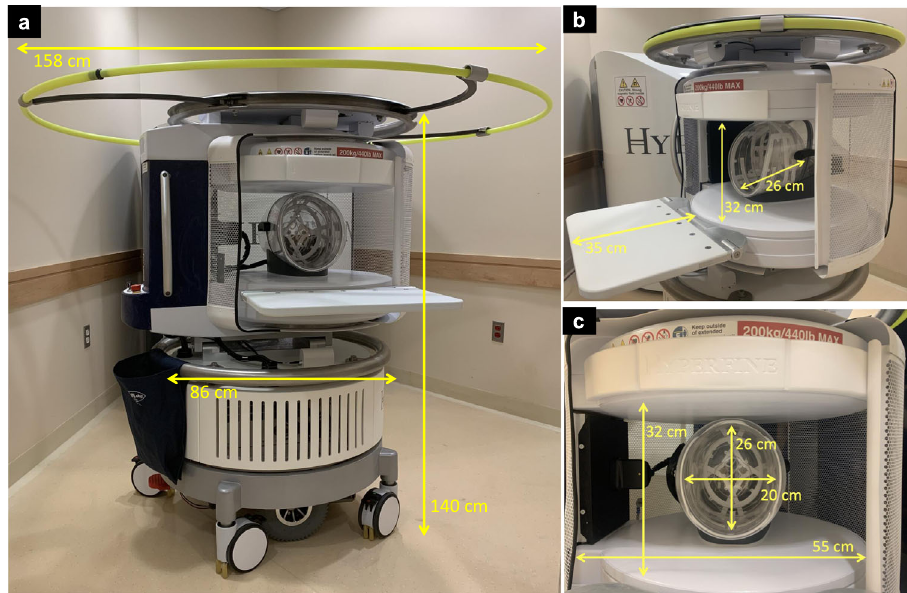
Fig. 1 Portable (0.064T) magnetic resonance imaging device dimensions. a The portable MRI (pMRI) device has a height of 140 cm and a width of 86 cm. The critical 5 Gauss (0.5 mT) boundary around the scanner extends into a circle with a diameter of 158 cm. b The pMRI device is positioned at the head of the patient ’ s hospital bed. The scanner bridge (35 cm) adjoins the hospital bed with the pMRI device and the patient ’ s chest height and head and neck lengths are positioned within the vertical clearance between magnets (32 cm) and the head coil length (26 cm), respectively. c The patient ’ s head is positioned within the single channel transmit, 8-channel receiver head coil (26 × 20 cm) and the RF shield is closed for scan acquisition, which creates a horizontal clearance of 55 cm. Table 1 Demographic and clinical characteristics of study population.